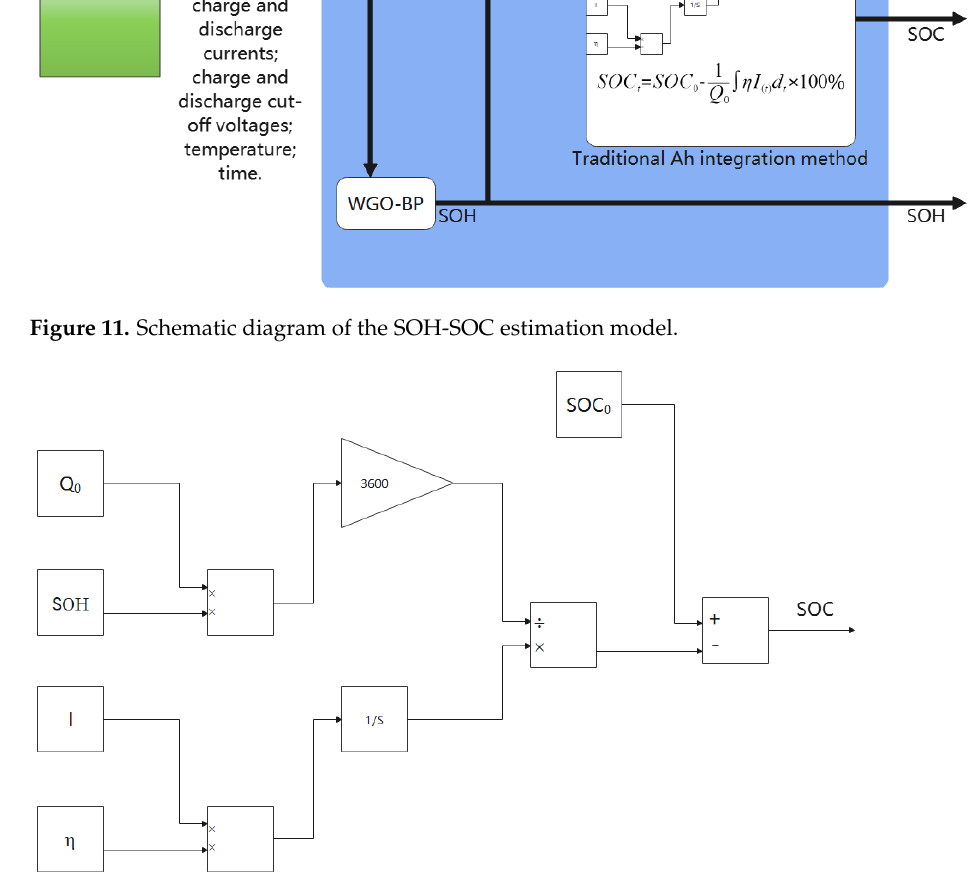
Figure 12. Simulink structure of the time-integration method.